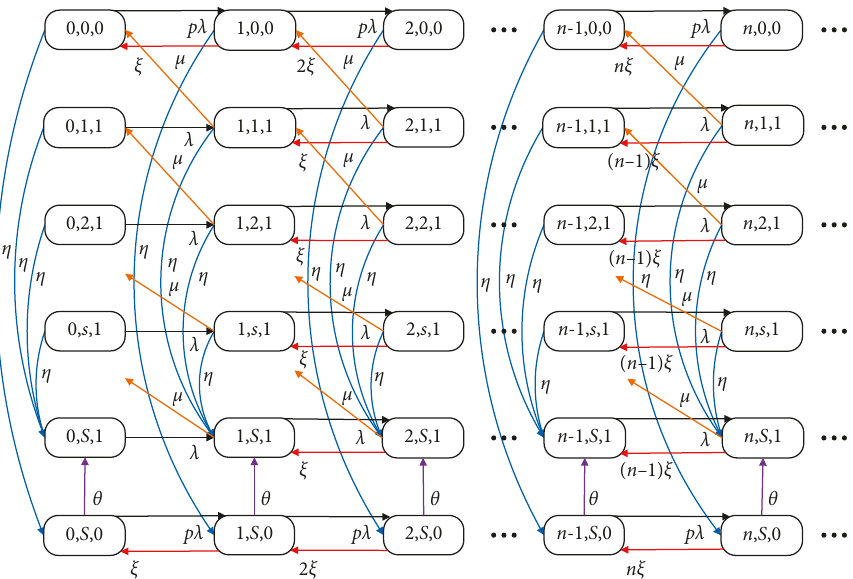
Figure 1: State-transition diagram of the QIS